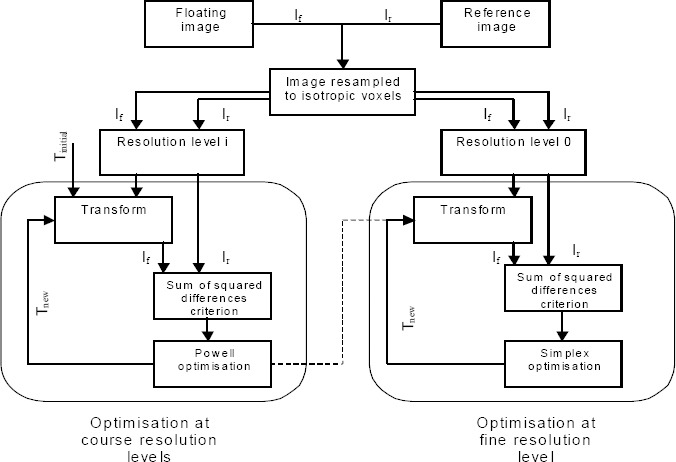
Diagram of Multi-resolution Multi-optimisation algorithm using a hierarchical transformation model and SSD similarity. If and Ir represent floating and reference images, Tinitial and Tnew represent transformation parameters.